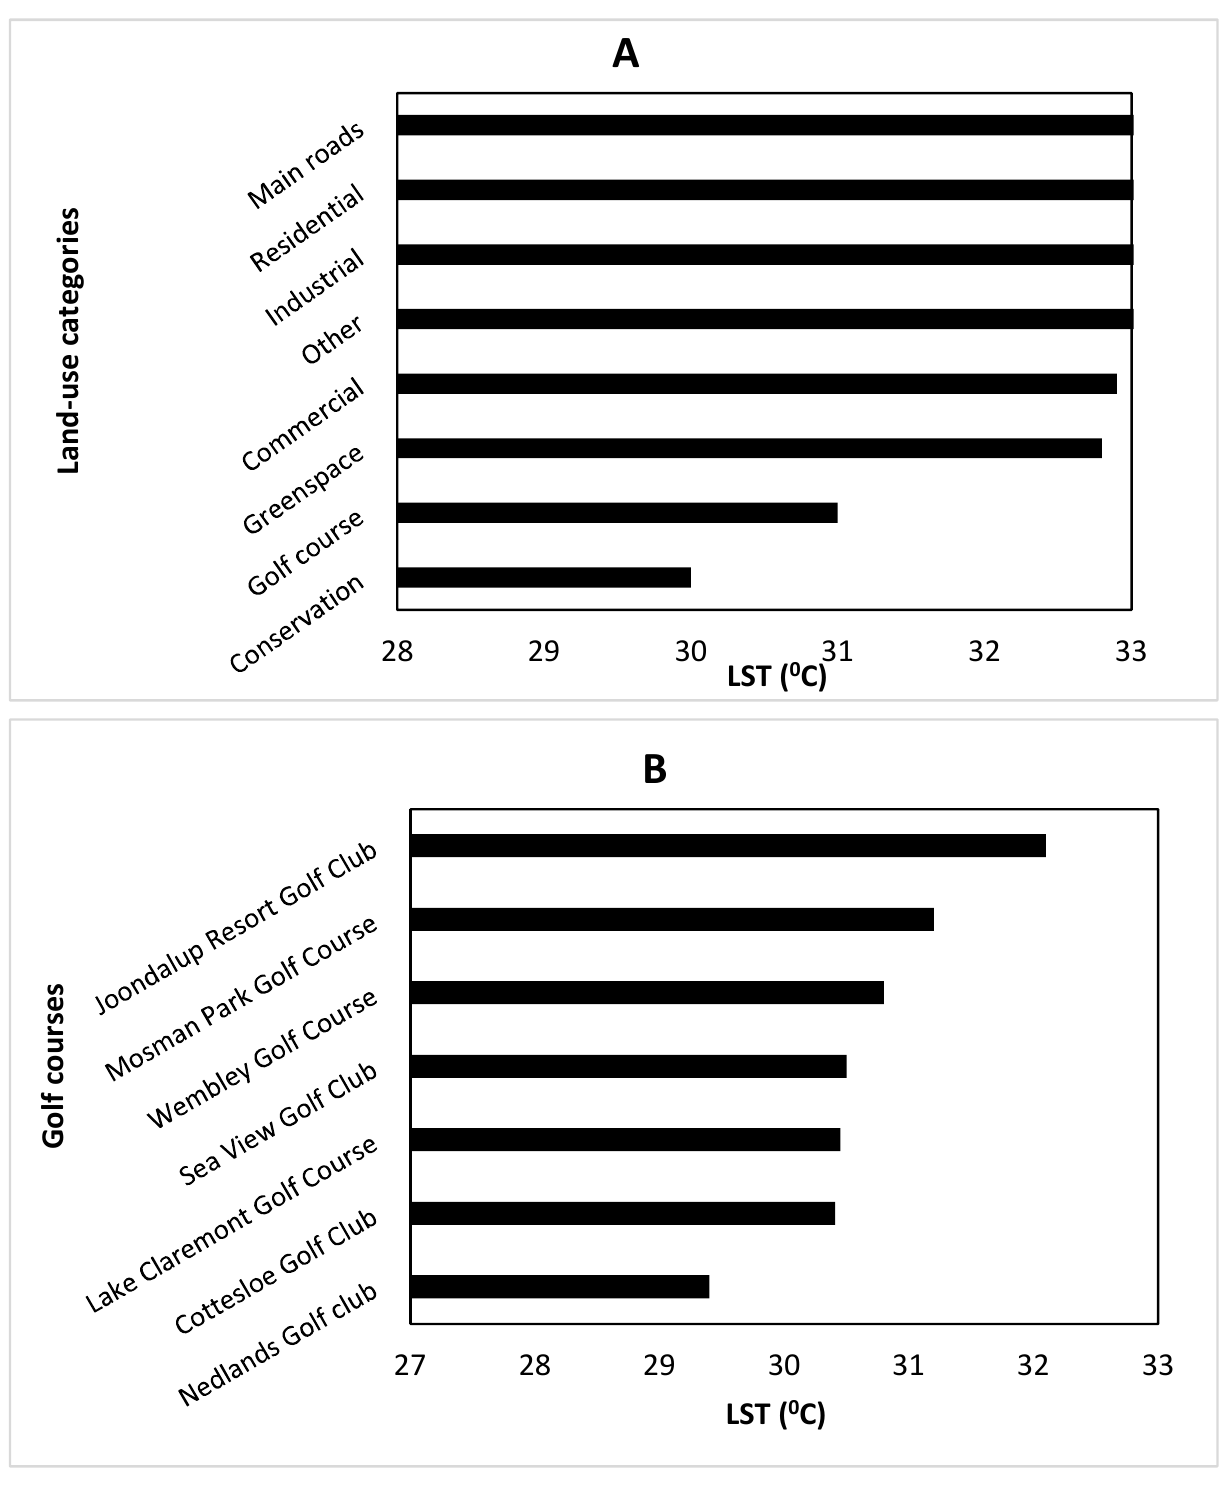
Figure 3. Variation in the mean values of LST among ( A ) land-use categories and ( B ) the seven golf courses.